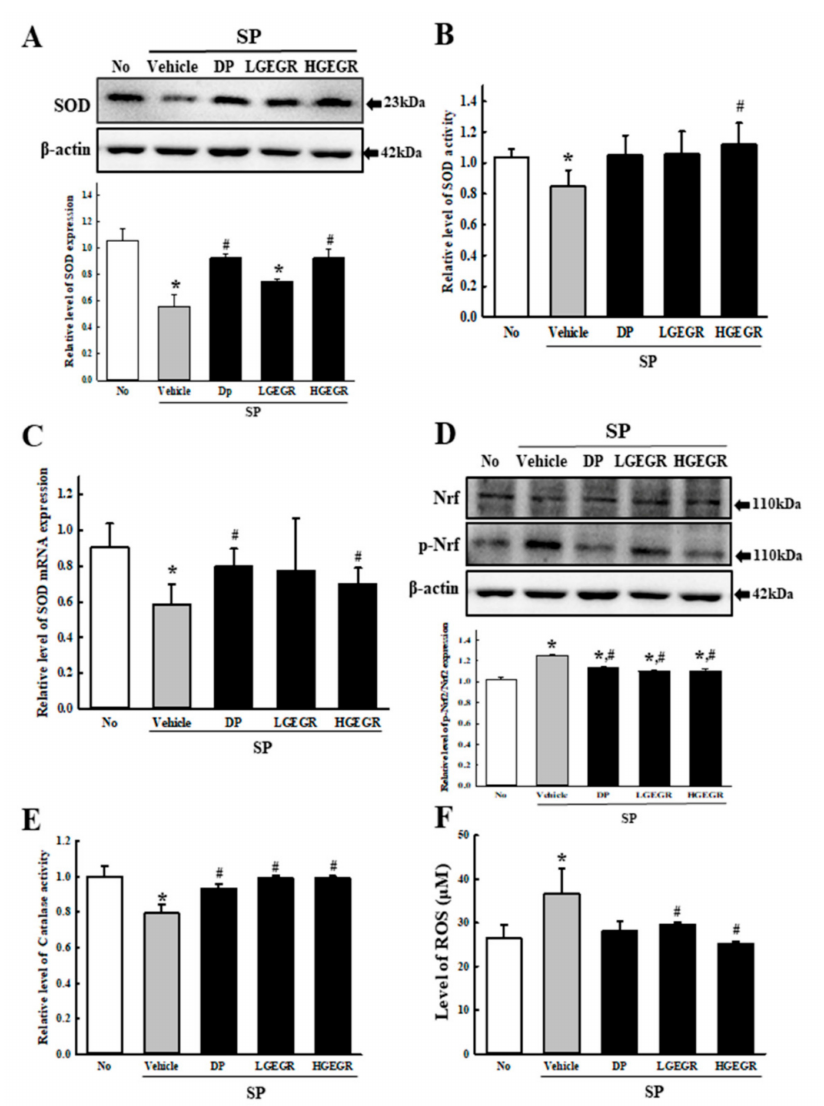
Figure 2. SOD activity, catalase (CAT) activity, and ROS concentration in brain of SP + GEGR treated mice. ( A ) Total tissue homogenates were prepared from brains of SP-injected mice treated with